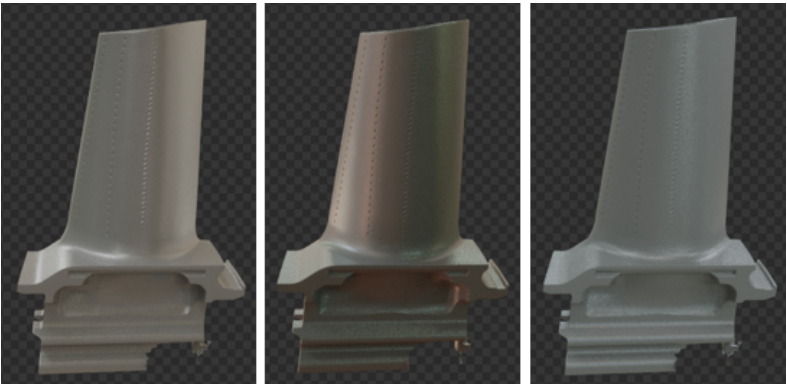
Figure 5. Compared to point lights, image-based lighting with an HDRI creates a more balanced ambient illumination. The images were rendered with three different HDRIs with E IBL =